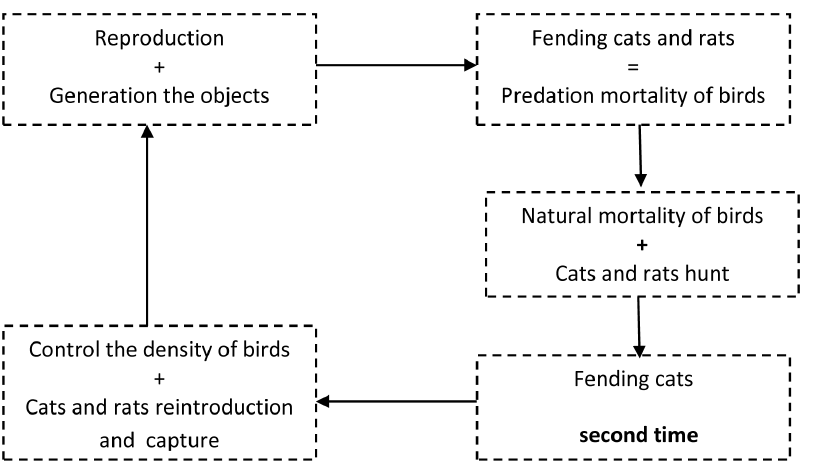
Figure 4. Scheme proposed for the PDP model. The loop is formed by five modules that are applied sequentially. In three of the modules, two processes are applied in parallel. The objects associated with each of the animals evolve simultaneously in the different modules.